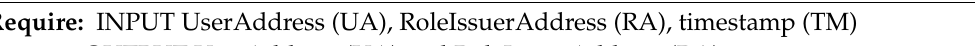
Algorithm 2 Algorithm for removeUser